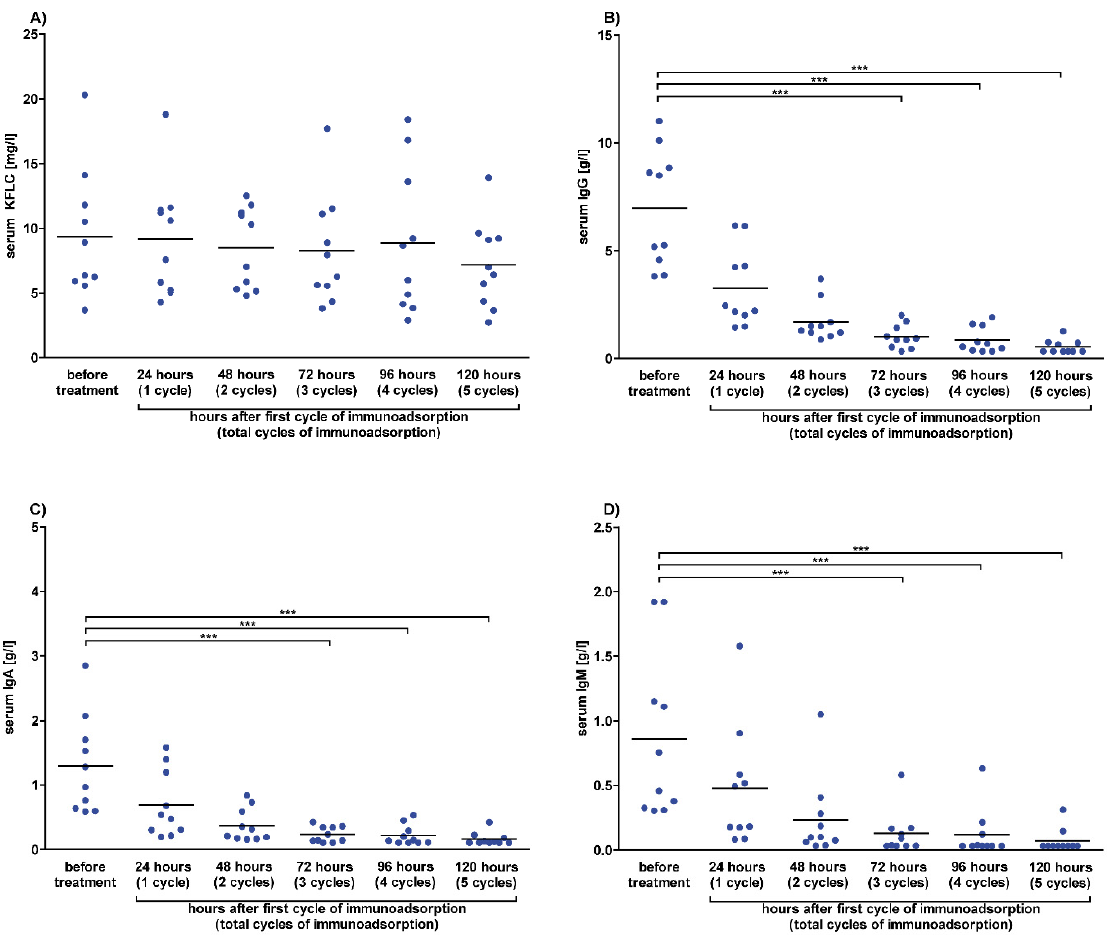
Figure 5. Serum concentrations after immunoadsorption in prospective patients. Serum concentrations of patients whose data and samples were collected in 2018 and 2019 are shown. Depicted are serum concentrations of kappa free light chains (KFLC) ( A ), immunoglobulin type G (IgG) ( B ), IgA ( C ), and IgM ( D ). Blood samples were taken before and after 24, 48, 72, 96, and 120 h of treatment with one cycle of immunoadsorption per day (n = 10). p -values of significant differences are illustrated as asterisks.